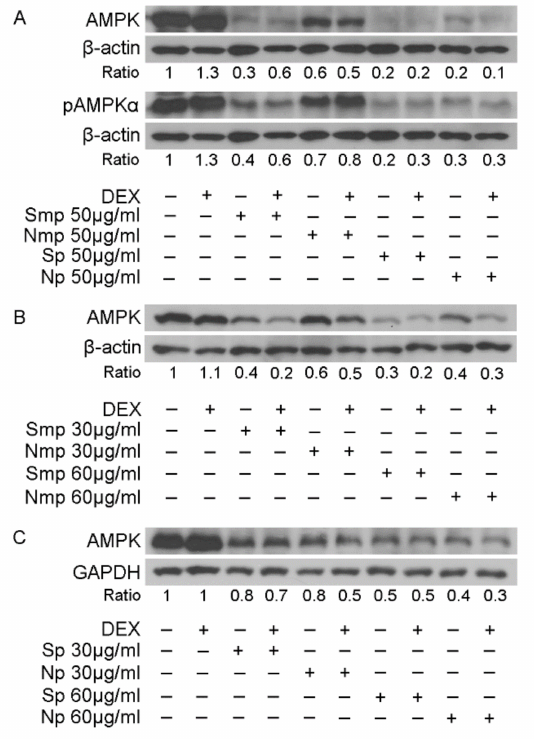
Figure 5. Evaluation of the effect of medium-polar and polar leaves fractions of south and north Chios mastiha tree on AMPK, pAMPK α protein levels. Western blot analysis of β -actin, GAPDH, AMPK, pAMPK α , protein levels in cell extracts from HEK293 cells treated with 30, 50, and 60 µ g/mL of leaves fractions and/or 10 nM DEX, for 1 h ( A ) and 48 h ( B , C ) in hormone-depleted medium, was performed using commercially provided